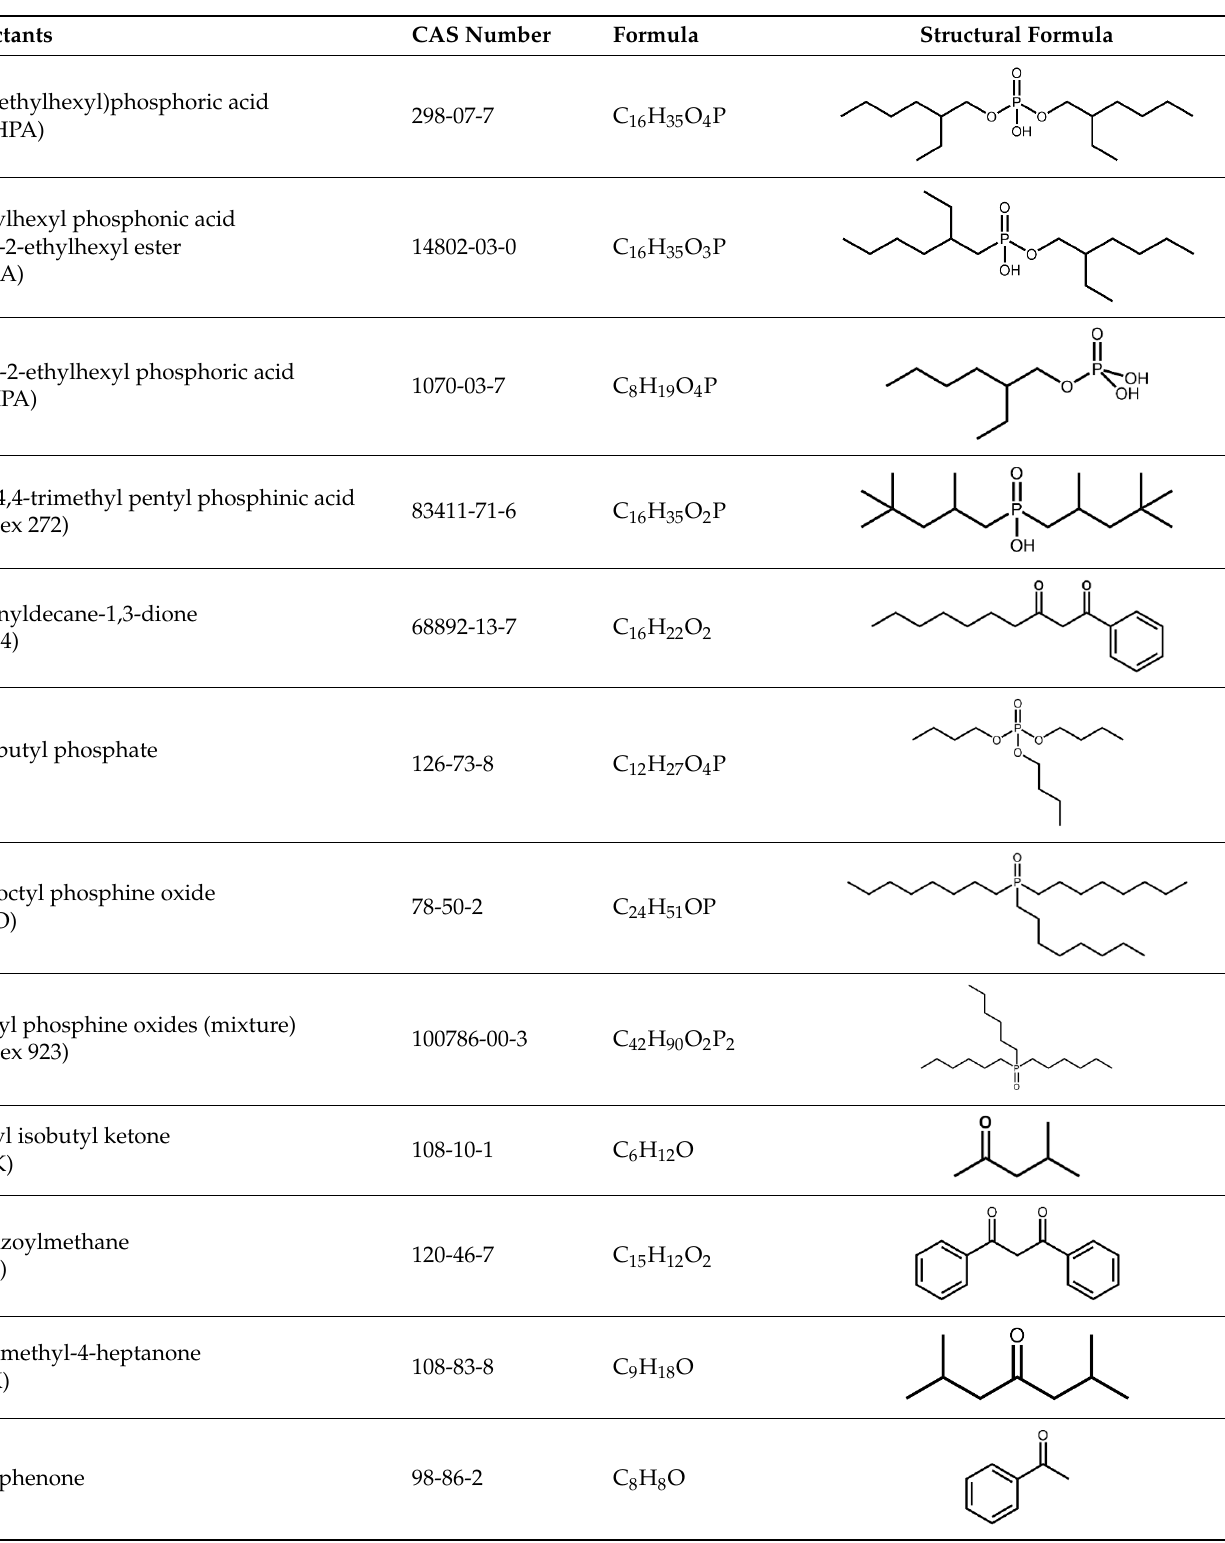
Table 10. Solvents used for the extraction and recovery of lithium from brines and leachates, adapted from [63,179,200]. Extractants